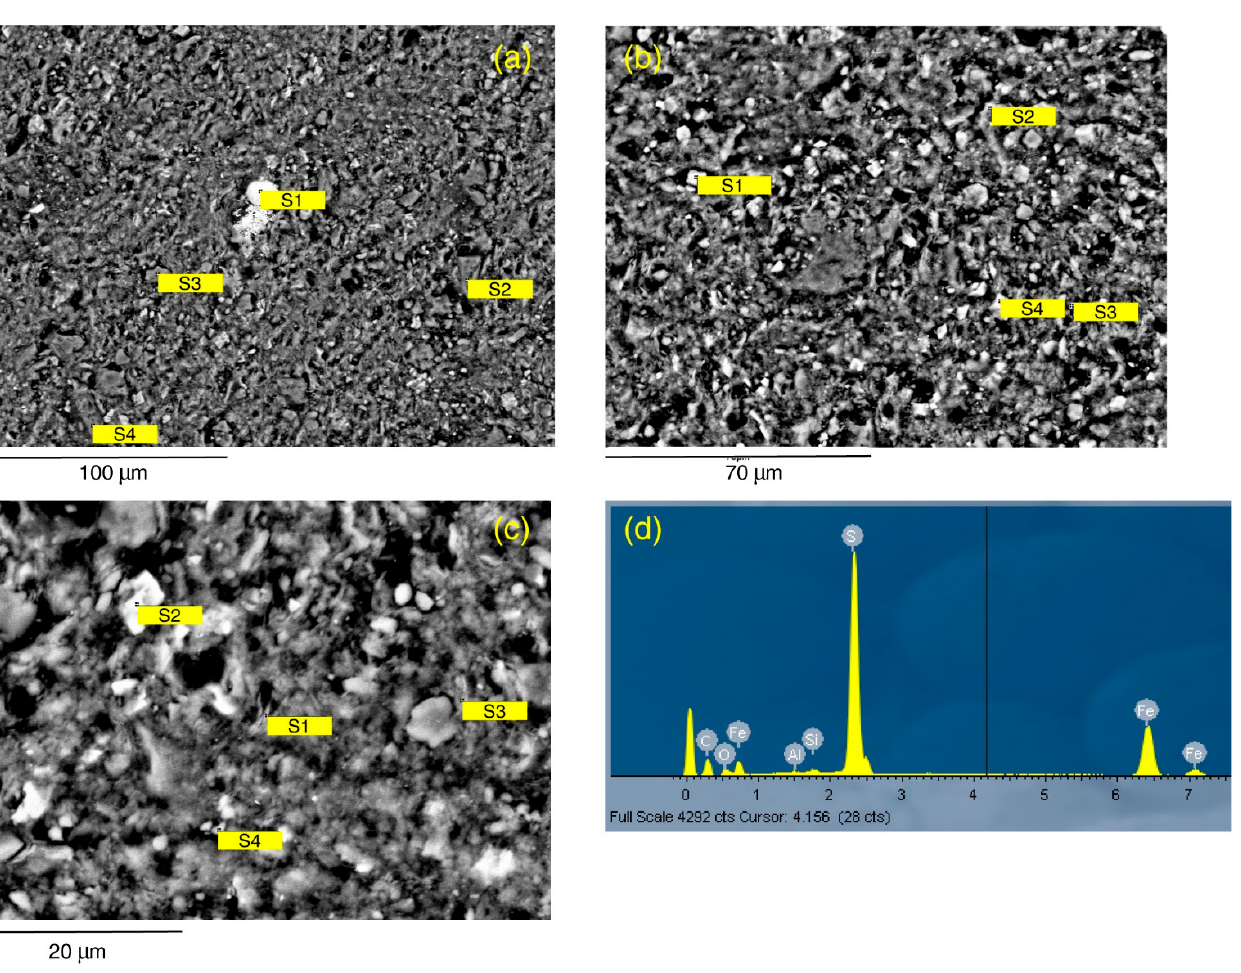
Figure 7. SEM-EDS data of C2 sample in thin section. ( a ) General aspect at low magnification scale showing a dominant fine clayey matrix that includes larger crystals at the analytical Site 1. S1: pyrite; S2-S4: quartz. ( b ) Texture and mineralogy of the analytical Site 2. S1: dolomite-siderite; S2: illite, S3: anatase; S4: dolomite-siderite. ( c ) Texture and mineralogy of the analytical Site 3. S1: kaolinite; S2: dolomite-siderite; S3: muscovite; S4: illite-chlorite. ( d ) EDS spectrum of Site 1 in panel ( a ), S1: pyrite. Mineral compositions are related to spectrum for site in Table 4.